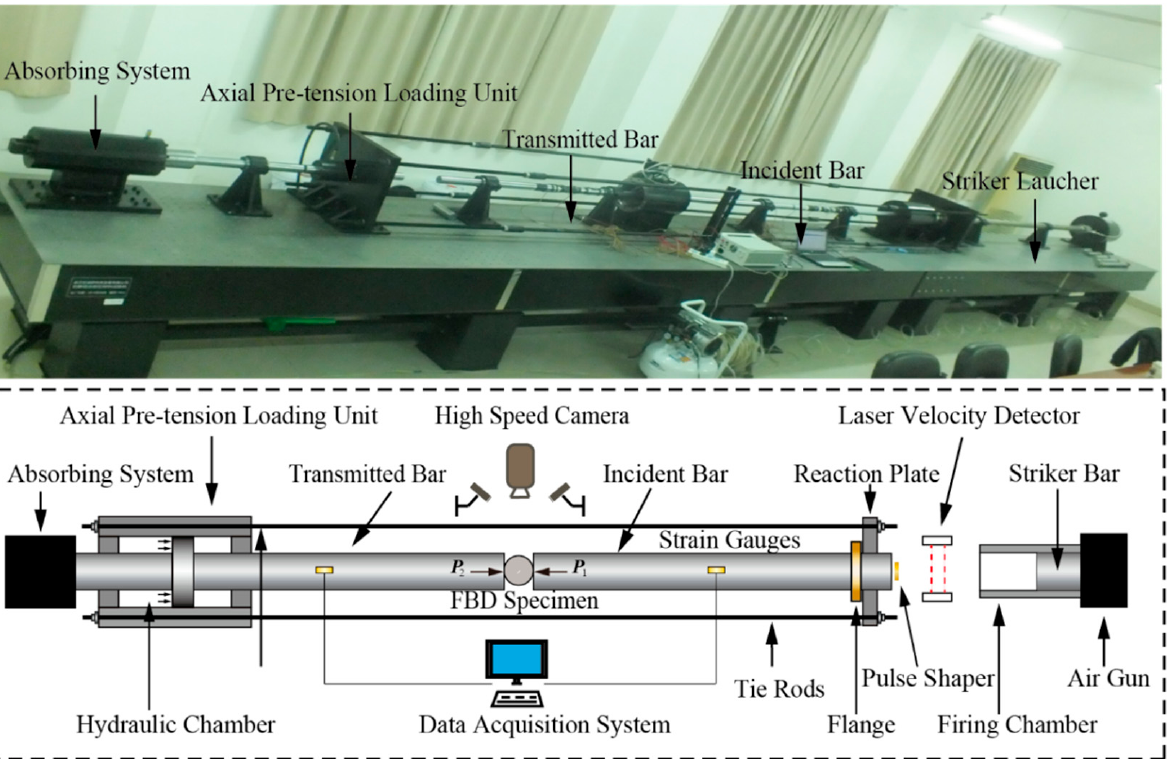
Figure 1. Modified split-Hopkinson pressure bar device.